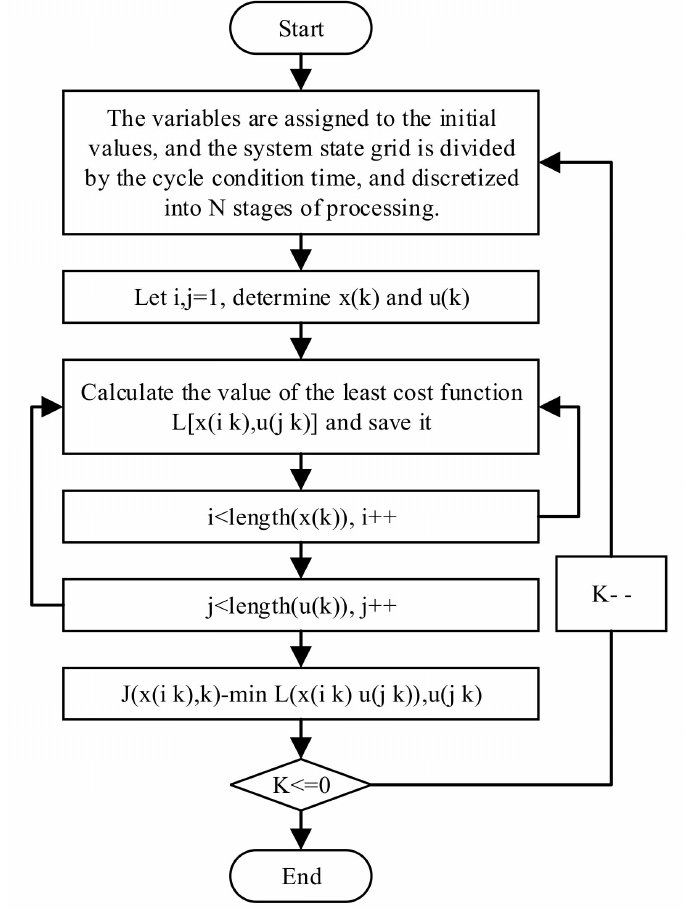
Figure 9. Flow chart of the dynamic programming